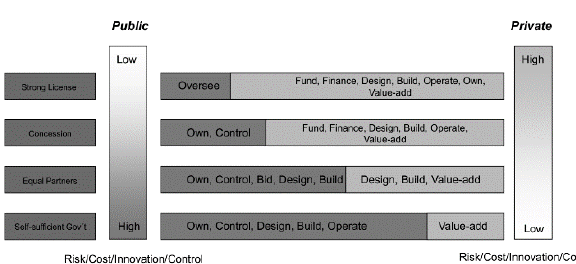
Figure 1 Public-Private Cooperation